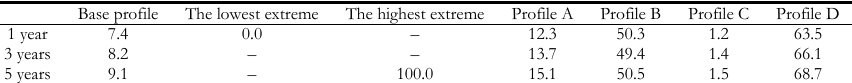
Estimated probability of working in a Region different from the one of residence, by individual